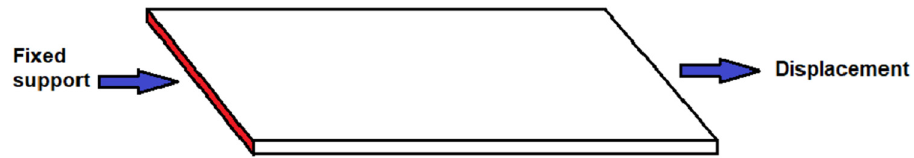
Figure 2: Schematic view of boundary conditions of the perforated sheet metal.